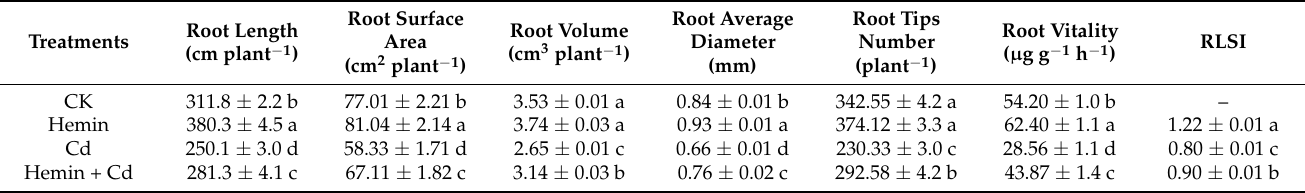
Table 3. Effects of hemin on root morphological traits (root length, surface area, volume, mean diameter, and number of root tips), root vitality and the root length stress tolerance index (RLSI) under Cd stress.